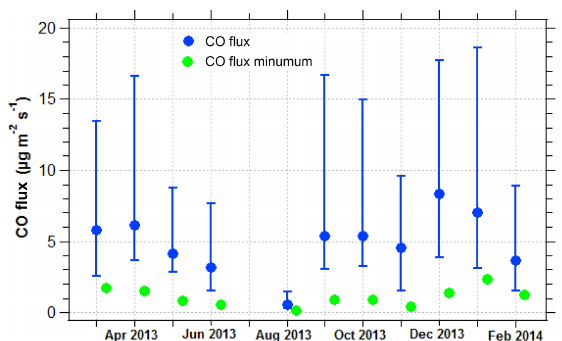
Figure 8. The estimated monthly average CO emission flux, which is based on the mean diurnal cycle of CO mixing ratios of each month for two conditions: (i) with data of all days (CO flux; blue dot) with lower and upper ends of the bar representing 25th and 75th percentile, respectively, and (ii) with data of morning hours (CO flux minimum; green dot) in which zero emission is assumed for the other hours of the day. The fluxes for July were not estimated as there were insufficient (less than 15 days) data of concurrent CO and mixing layer height. It is expected that the F CO and F CO July should fall between values for June and August